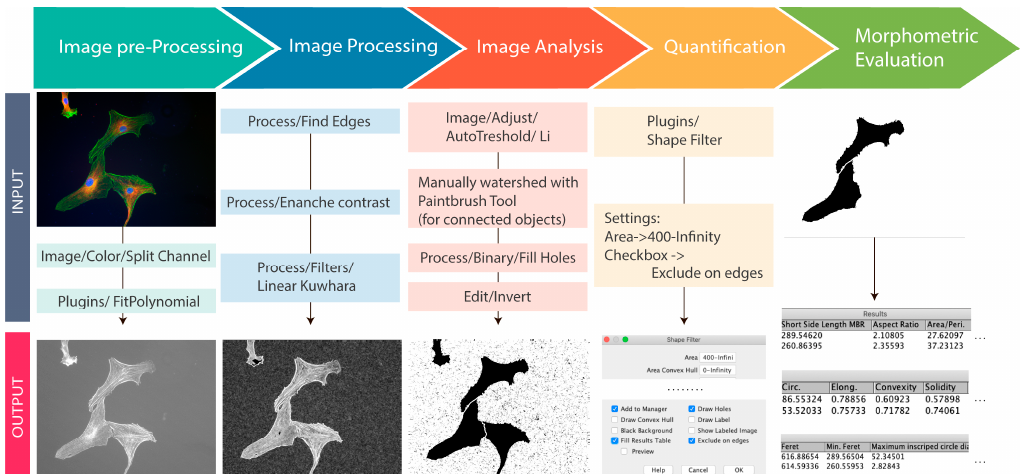
Figure 3. Schematic of a computational workflow for morphometric measurement of human adult mesenchymal stem cells. When working with RGB images, the first step is to split the colour channel into 8-bit grey colour. In most cases, it is necessary to correct the non-uniform illumination and then to convert the image into a binary image to make easier the identification of foreground objects. This allows analysis and computing statistics of the objects in the image. The procedure is summarized in